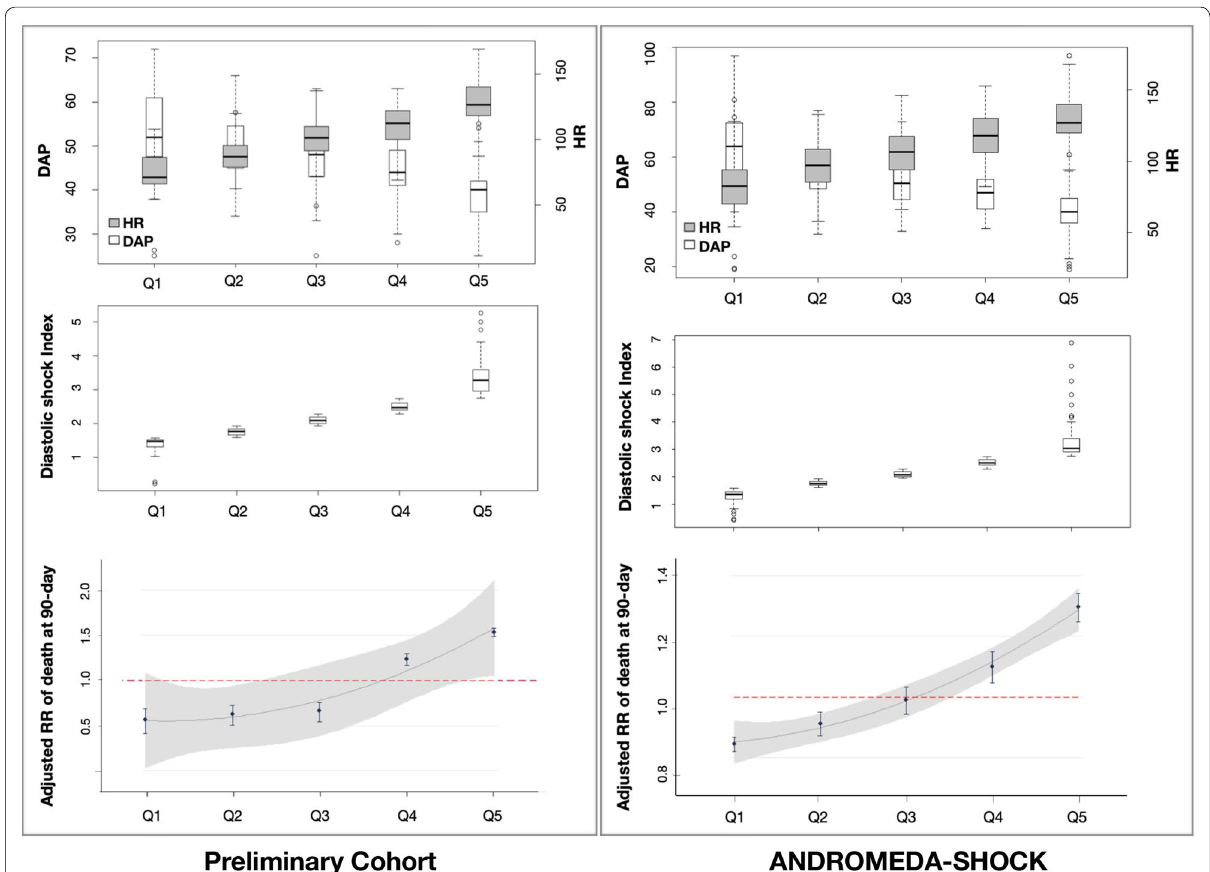
Fig. 1 Relative risk of death at day‑90 according to pre‑vasopressor diastolic shock index (Pre‑VPs/DSI) or vasopressor start (VPs/DSI) partitions in the preliminary and ANDROMEDA SHOCK populations. Diastolic shock index values obtained from just before the start of vasopressor (in preliminary cohort) and at the start vasopressor support (in ANDROMEDA‑SHOCK) were partitioned into 5 quantiles (Q1 to Q5). Distribution of heart rate (HR) and diastolic pressure (DAP) (top) and their respective diastolic shock index distribution (middle) are presented through the quantile distribution. Boxplots (top and middle) delineate the interquartile range, the median is shown as a line in the middle of the box, and tails represent the 95% range. Coefficients derived from a logistical regression were used to calculate the cut‑off value of the diastolic shock index (DSI) detecting the mean risk of mortality of the entire population at 28 days. This point was used as the reference to calculate the adjusted relative risks, in such a way that a relative risk of 1 represents the mean risk of the respective population (bottom). The mean risk and 95% confidence interval (error bars at the bottom) for each percentile were calculated after multivariate adjustment (Cox proportional‑hazards model) for the covariables: age, gender, SOFA score day‑1, initial arterial lactate and pH, and resuscitation fluids from VP to 8H. The gray zone represents the 95% confidence interval for the Cox regression (continuous line) across the complete population, assuming the diastolic shock index as a continuous variable. Note that adjusted relative risk of death increases as diastolic shock index also does through the quintile